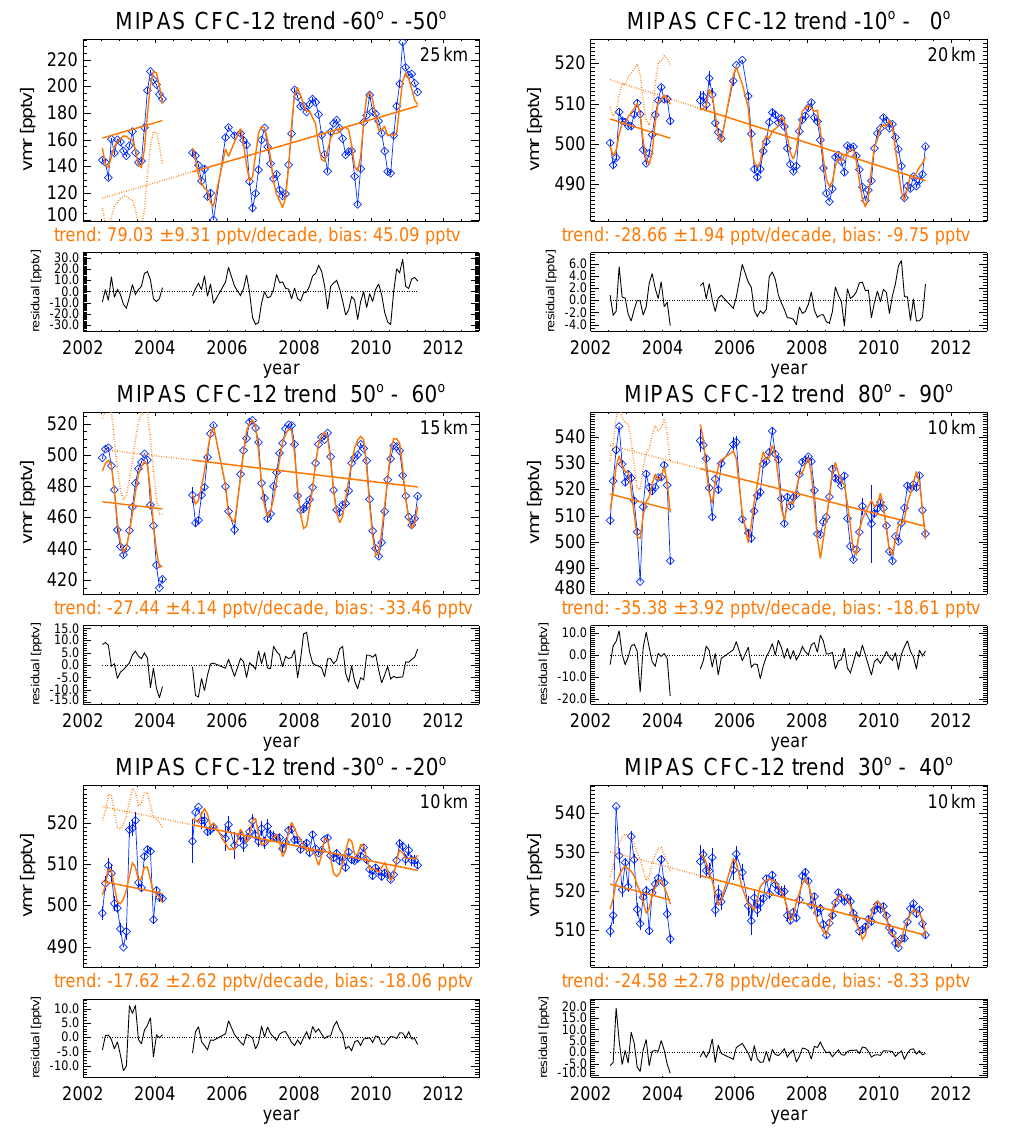
Fig. 14. Temporal evolution of CFC-12 for southern mid-latitudes (50 ◦ S to 60 ◦ S) at 25 km (top left panel), inner tropics (0 ◦ S to 10 ◦ S) at 20 km (top right panel), northern mid-latitudes (50 ◦ N to 60 ◦ N) at 15 km altitude (middle left panel), and northern polar latitudes (80 ◦ N to 90 ◦ N) at 10 km altitude (middle right panel) southern subtropics (20 ◦ S to 30 ◦ S) at 10 km altitude (lower right panel), and northern mid-latitudes (30 ◦ N to 40 ◦ N) at 10 km (lower right panel). Details as for Figure 11.